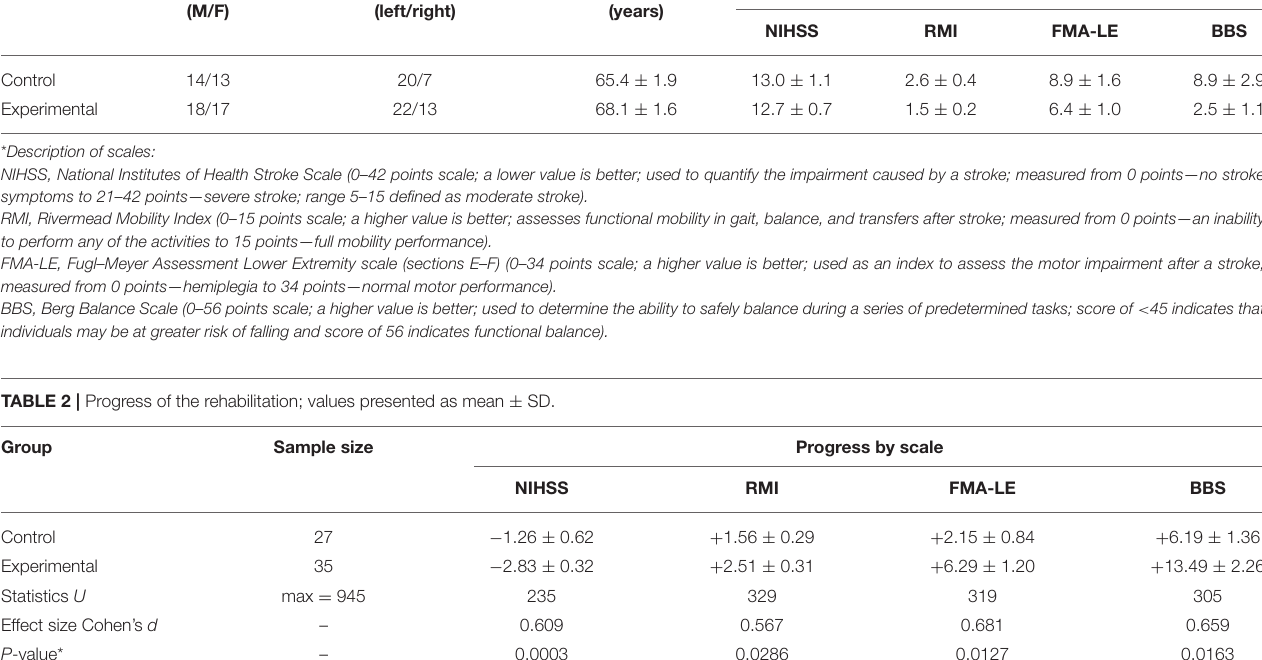
TABLE 1 | Clinical data of patients included in the study; values presented as mean ± SD. Group Gender Stroke pool localization Age Points by scale* (M/F) (left/right) (years)